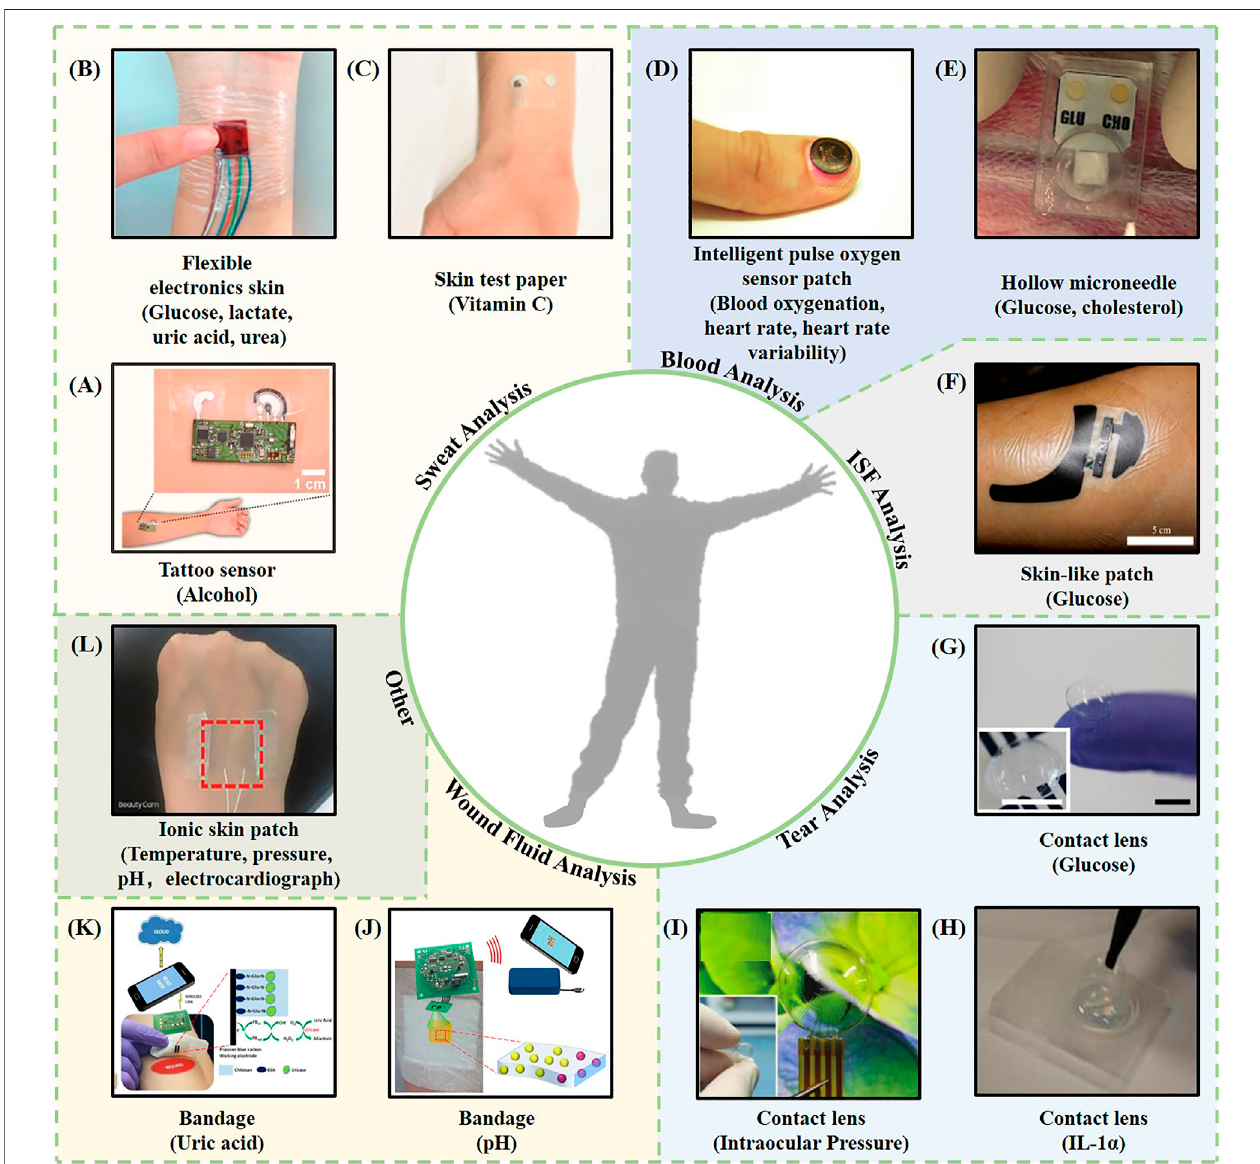
FIGURE 1 | Representative examples of intelligent wearable sensors based on bio fl uids. (A) A wearable tattoo sensor for alcohol detection in sweat (Kim et al., 2016). (B) A fl exible electronic skin based on a piezoelectric biosensor matrix for monitoring of lactic acid, glucose, uric acid, and urea (Han et al., 2017). (C) A skin test paper used for vitamin C monitoring (Sempionatto et al., 2020). (D) An intelligent pulse oxygen sensor patch that outputs information such as the blood oxygen, heart rate, and heart rate variability (Kim et al., 2017b). (E) A one-touch-activated blood multidiagnostic system (OBMS) for monitoring blood glucose and cholesterol (Li et al., 2015). (F) A skin-like patch for noninvasive blood glucose monitoring (Chen et al., 2017). (G) A contact lens sensing device for monitoring blood sugar (Kim et al., 2017c). (H) A thermotherapy recessive lens for monitoring IL-1 α (Mak et al., 2015). (I) A contact lens sensor capable of continuous intraocular pressure monitoring (Liu et al., 2021). (J) A smart bandage for optical monitoring of pH (Kassal et al., 2017). (K) An intelligent bandage for monitoring the uric acid index in a wound (Kassal et al., 2015). (L) An ionic bioelectronic skin patch for monitoring of temperature, pressure, pH, and electrocardiogram data (Shi and Wu, 2021).